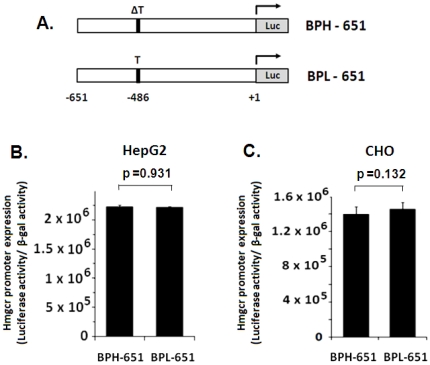
The ΔT-486T SNP in the mouse Hmgcr promoter is not functional.The BPH-651 and BPL-651 promoter/firefly luciferase reporter constructs harboring ΔT/T SNP at the -486 bp position (panel A) were generated as described in the Materials and Methods section. These constructs were transfected into HepG2 and CHO cells, along with co-transfected β-galactosidase expression plasmid. Cells were lysed 24–30 hrs after transfection and assayed for luciferase activity as well as β-galactosidase activity. Values shown in the bar graph are the Means ± S.E. of normalized luciferase activity (ratioed with respect to β-galactosidase activity) from at least three independent experiments. No difference in the activity between the BPH and BPL promoter was observed in HepG2 (panel B) and CHO cells (panel C).